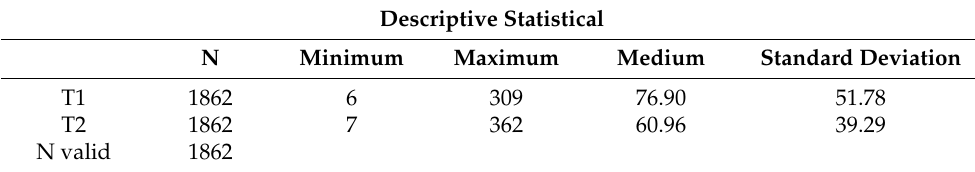
Table 2. Descriptive analysis of T1 and